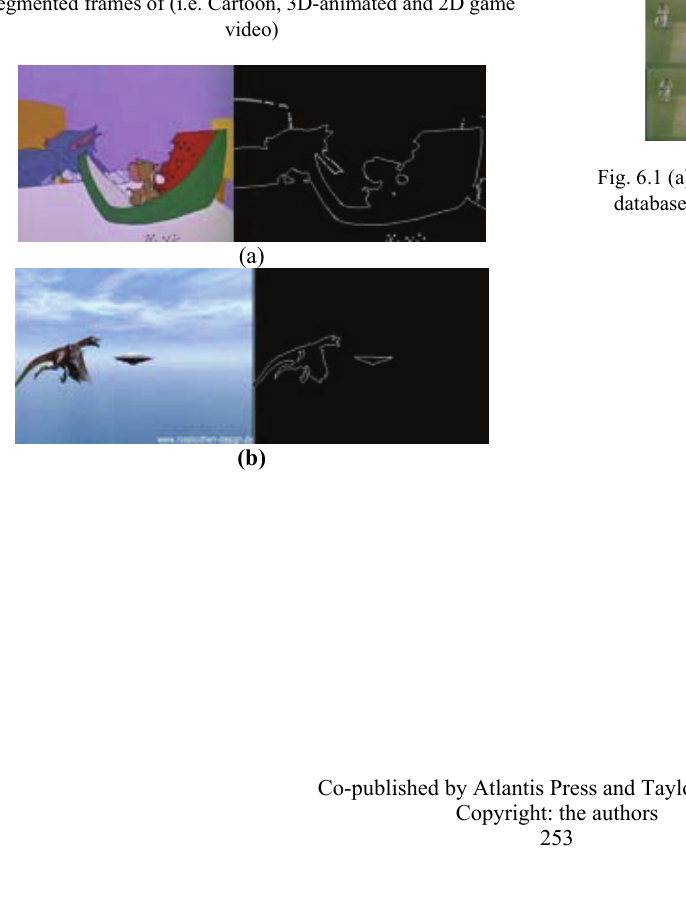
Fig. 5.6. Color histogram for normal frames and color segmented frames of (i.e. Cartoon, 3D-animated and 2D game